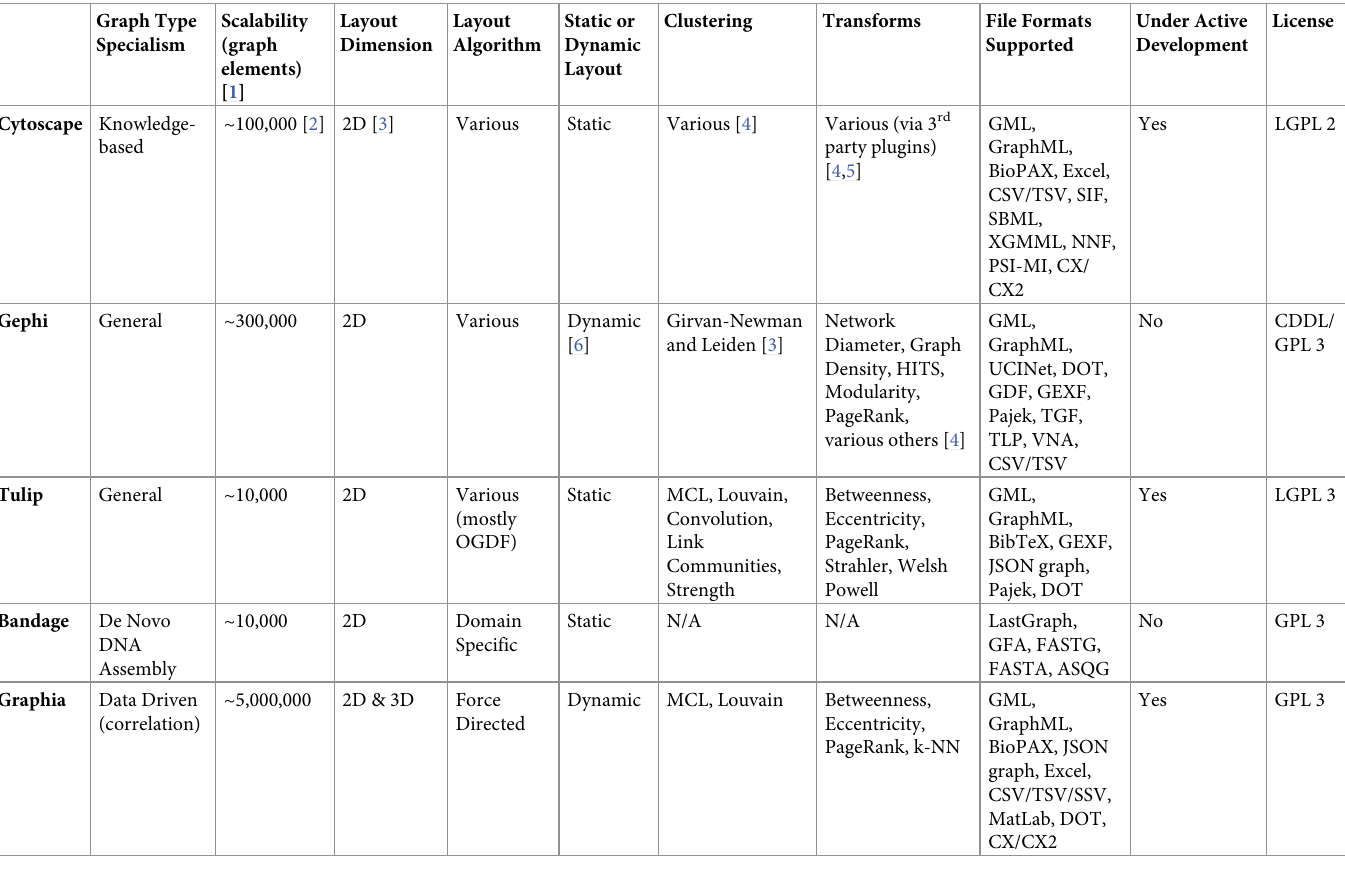
Table 1. Summary of network visualisation tools commonly used for the analysis of biological